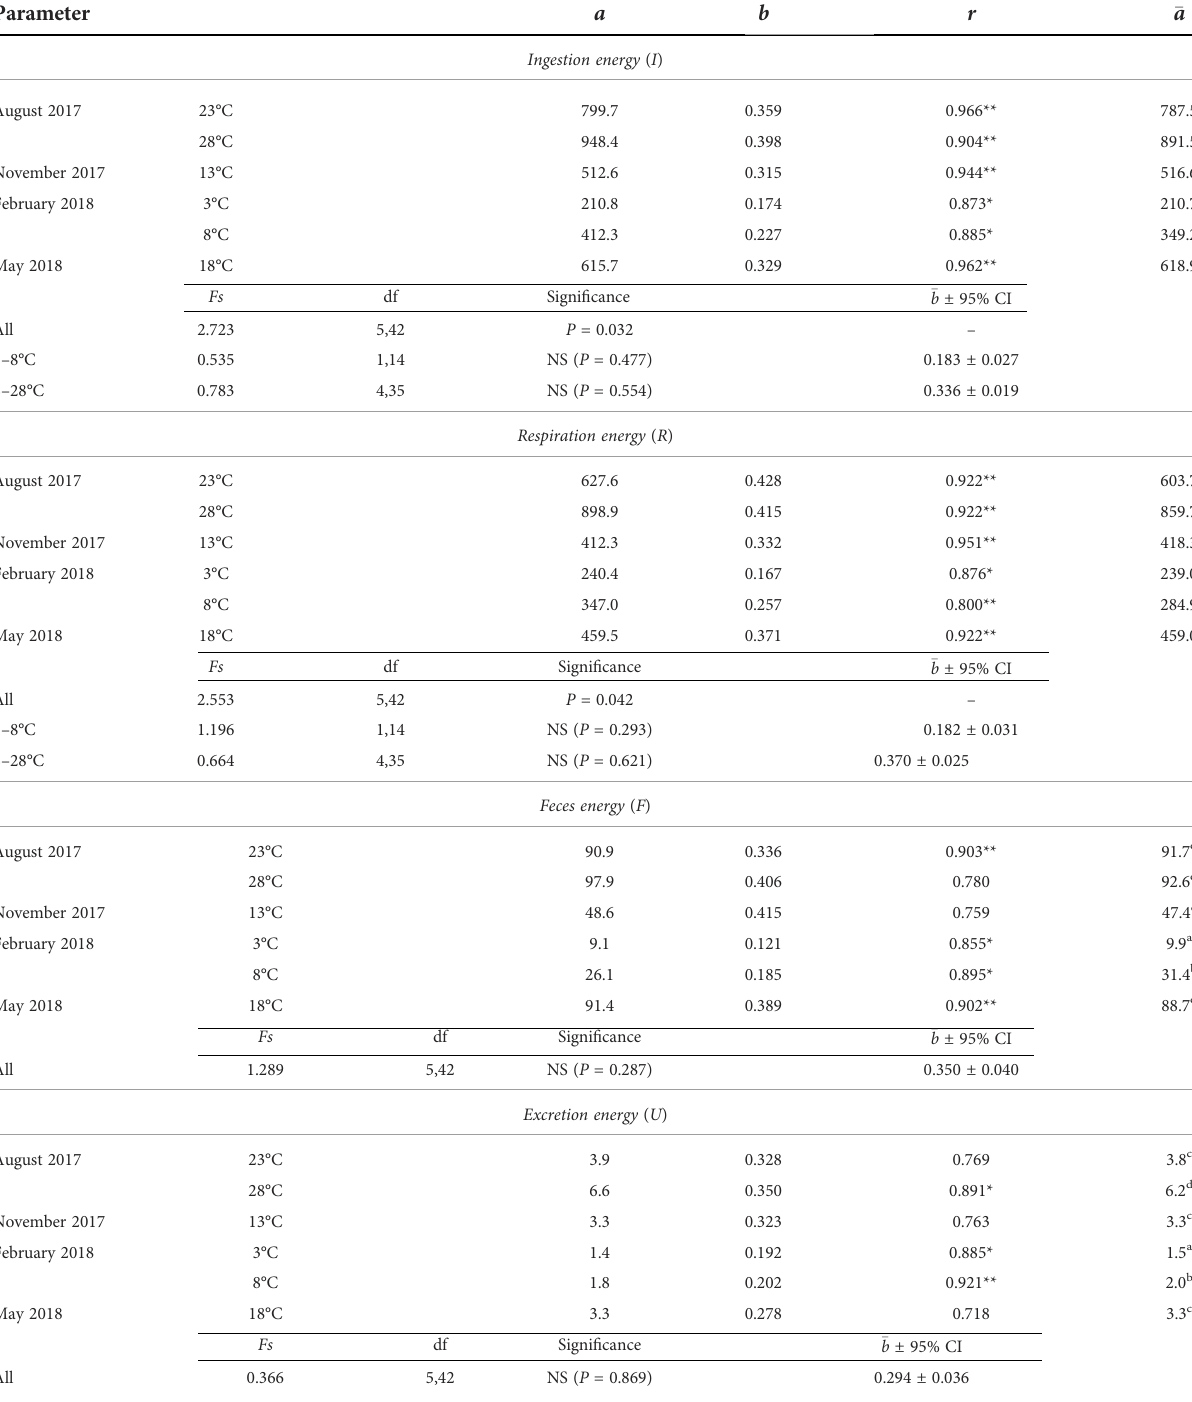
TABLE 2 Regression coef fi cients of allometric equation Y = aW b between physiological rate ( Y , J d – 1 ) and dry fl esh weight ( W , g) of the ark shell Anadara kagoshimensis at different temperatures.